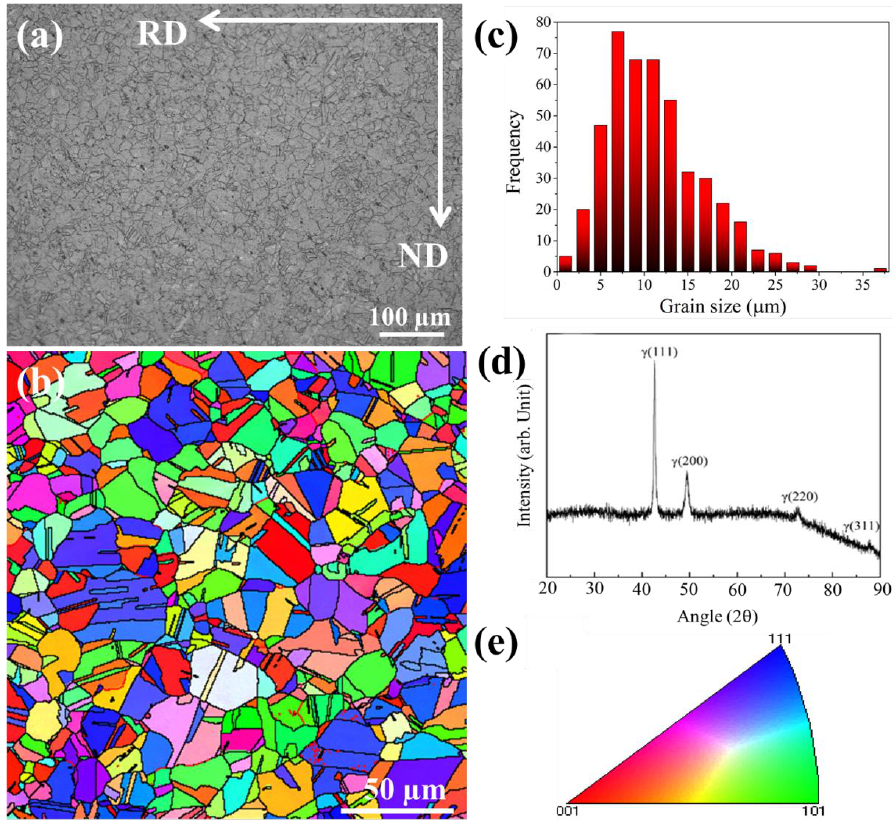
Figure 1. ( a ) OM of low-density steel along RD-ND plane; ( b ) IPF map of low-density steel along RD-ND plane; ( c ) grain size statistical analysis; ( d ) XRD of rolled steel; ( e ) legend map of corresponding the IPF map.